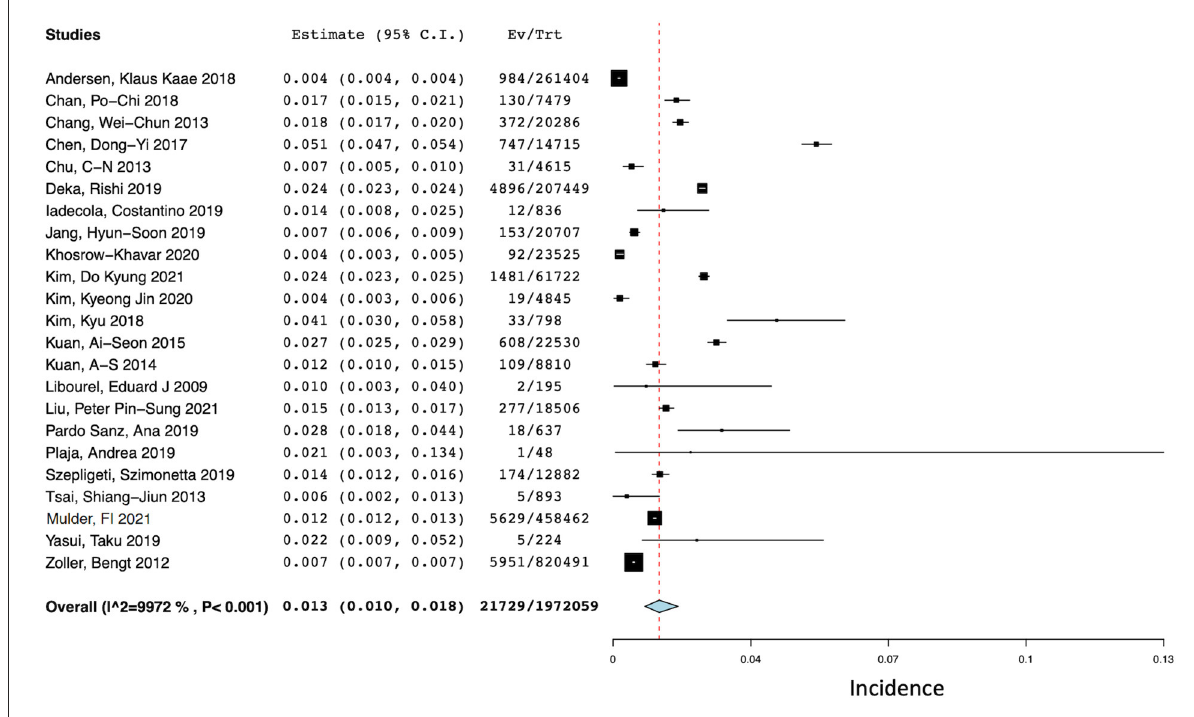
FIGURE3 Forest plot of the pooled incidence of ischemic stroke at 1 year after a diagnosis of cancer.